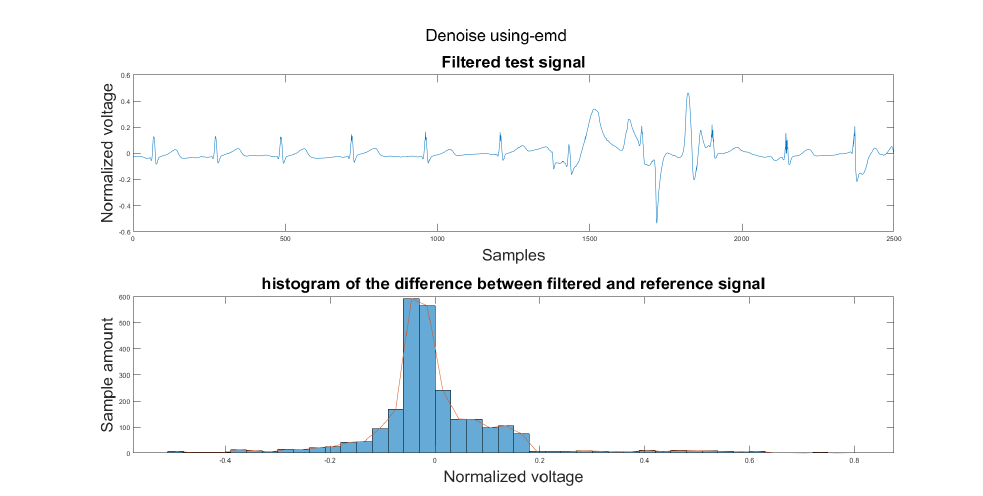
Figure A26. (1) Test signal, (2) histogram of the